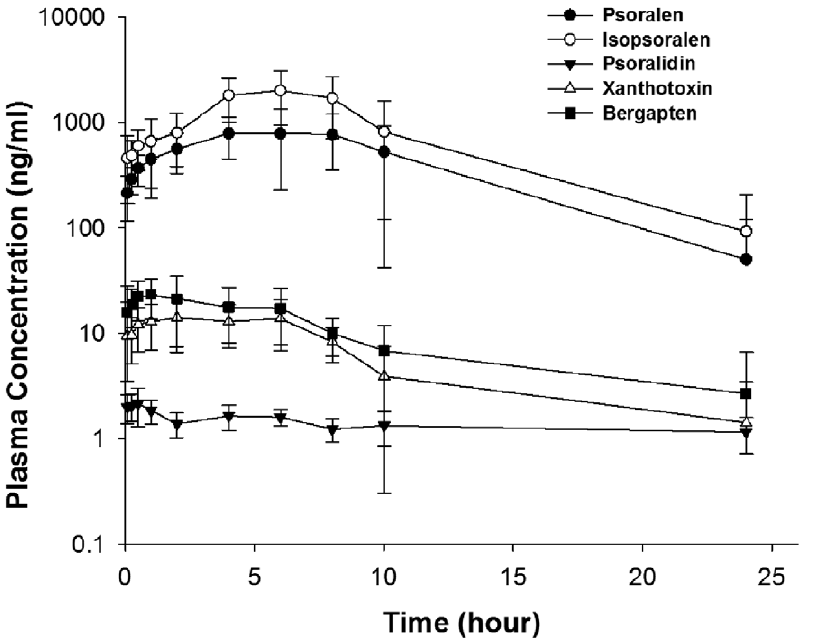
Figure 3. Plasma concentration-time curves for psoralen, isopsoralen, psoralidin, xanthotoxin, and bergapten in SD rats after single oral administration of BZ.